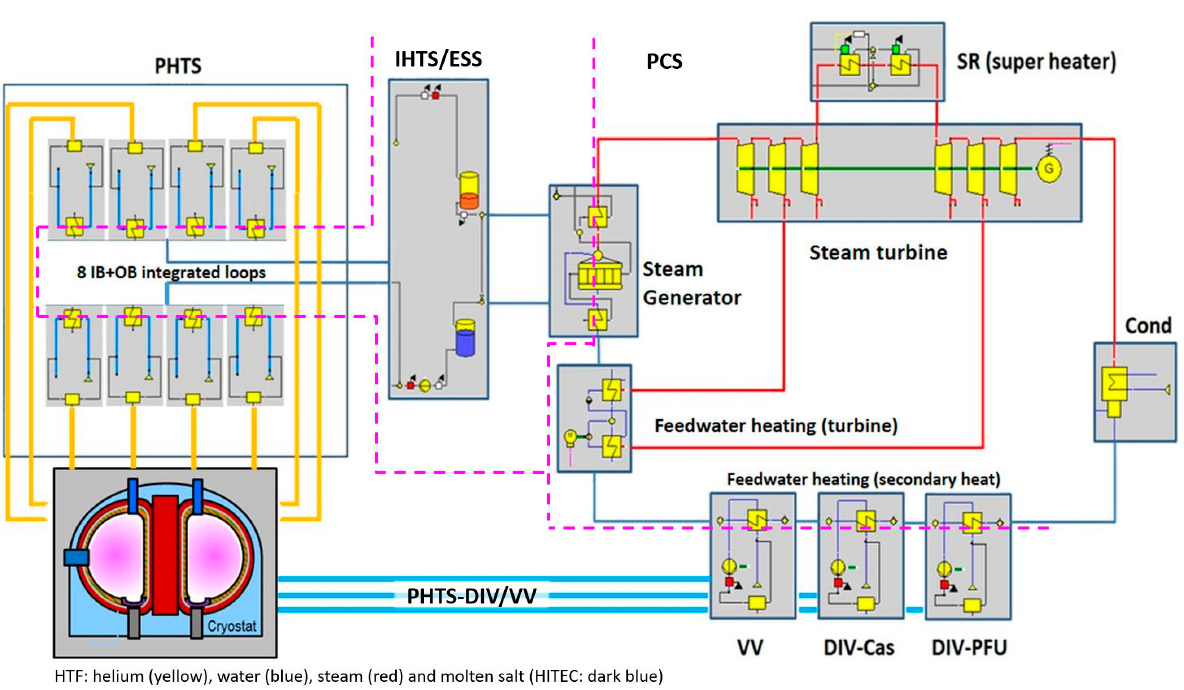
Figure 2. Overview of the DEMO HCPB ICD variant with PHTS, IHTS, and PCS indicating the different HTFs and the interfaces (dashed lines).